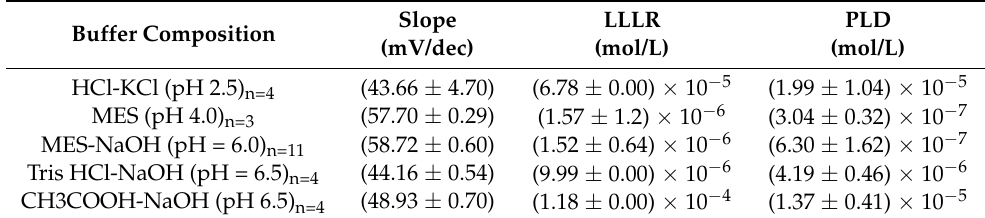
Table 3. Effect of the pH in the potentiometric response.